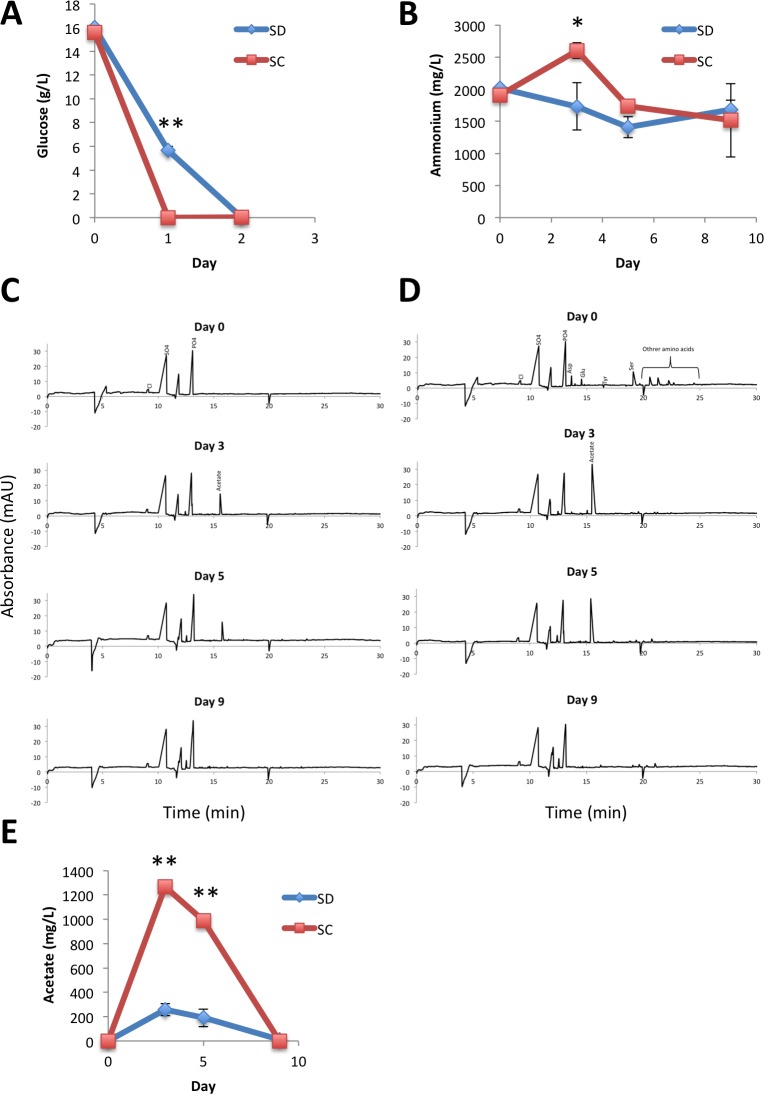
Changes in substance content of the medium during chronological aging.(A) Glucose concentration. (B) Ammonium concentration. (C), (D) Capillary electrophoresis analysis of the media. (E) Acetate concentration. Culture media of YOM36 cells grown in SD (C) or SC (D) as in Fig 1 were recovered at the indicated times and inorganic anions, organic acids and amino acids in the media were analyzed using the capillary zone electrophoresis method. Error bars represent the means ± SD (n = 3). *P<0.05; **P<0.01.